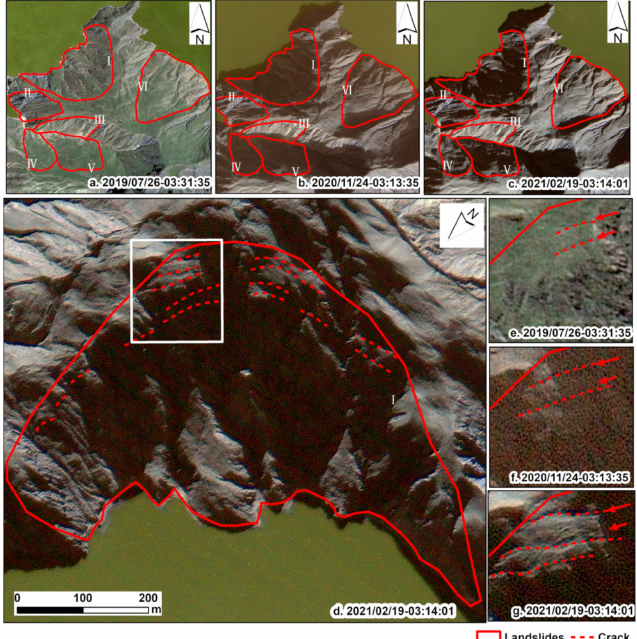
Figure 8. Multi-phase optical images of the Lijia Gorge landslide group. ( a ) Optical image of the Lijia Gorge landslide group on 26 July 2019, at 03:31:35 UTC. ( b ) Optical image of the Lijia Gorge landslide group on 24 November 2020, at 03:13:35 UTC. ( c ) Optical image of the Lijia Gorge landslide group on 19 February 2021, at 03:14:01 UTC. ( d ) Optical image of the No. I landslide on 19 February 2021, at 03:14:01 UTC. ( e – g ) Optical images of a zoomed-in section (see white box in d ) of the No. I landslide on ( e ) 26 July 2019, ( f ) 24 November 2020, and ( g ) 19 February